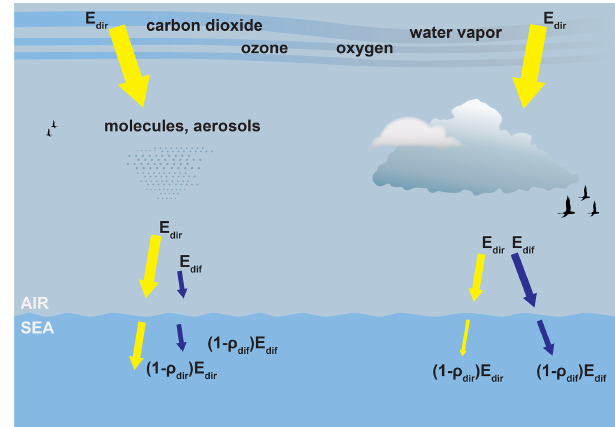
Figure 1. Irradiance pathways in OASIM under clear skies (left) and cloudy skies (right): E dir is the direct downwelling irradiance, E dif is the diffuse downwelling irradiance, and ρ dir and ρ dif are the direct and diffuse surface reflectances, respectively (the size of the arrows approximates the relative contributions; the figure is modi- fied from Fig. 1 of Gregg and Rousseaux,